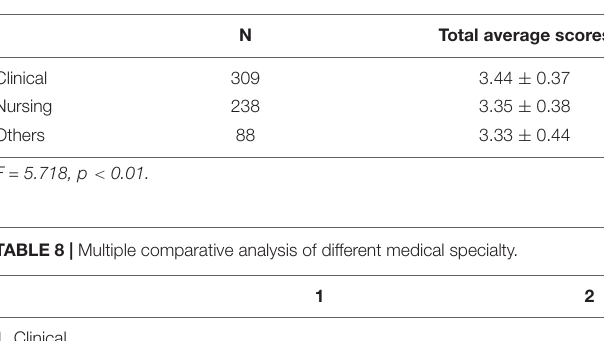
TABLE 7 | Comparison of medical students’ professional identity in different specialties.